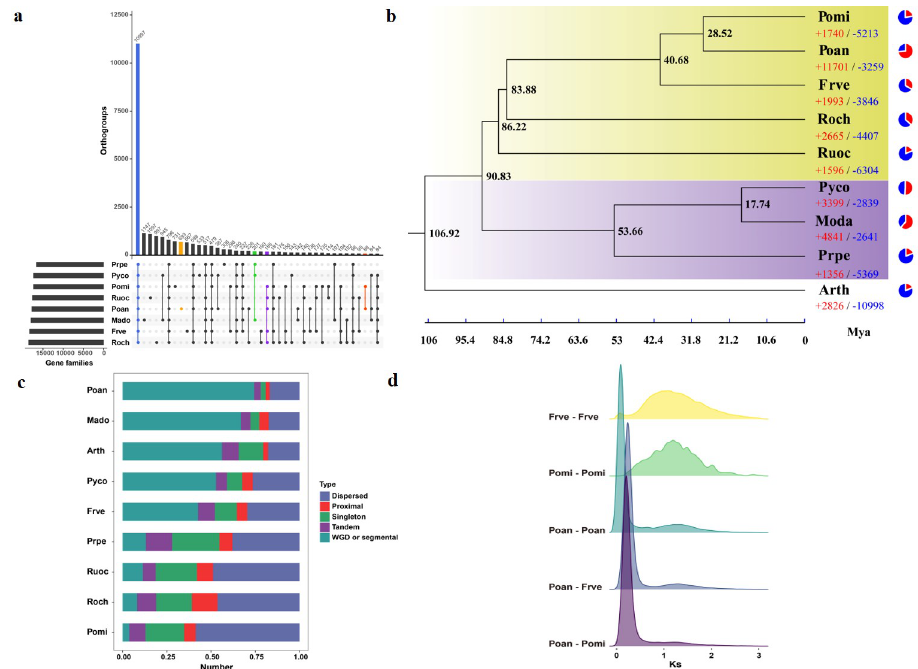
Figure 3. Evolution of the Poan genome. ( a ) Orthologous gene families among Rosaceae plants. ( b ) Phylogenetic relationship of Poan and eight other species. Herbaceous plants are shown with a purple background and woody plants are shown with a yellow background. ( c ) Gene duplication events among nine different species. ( d ) Ks distribution between Poan, Pomi and